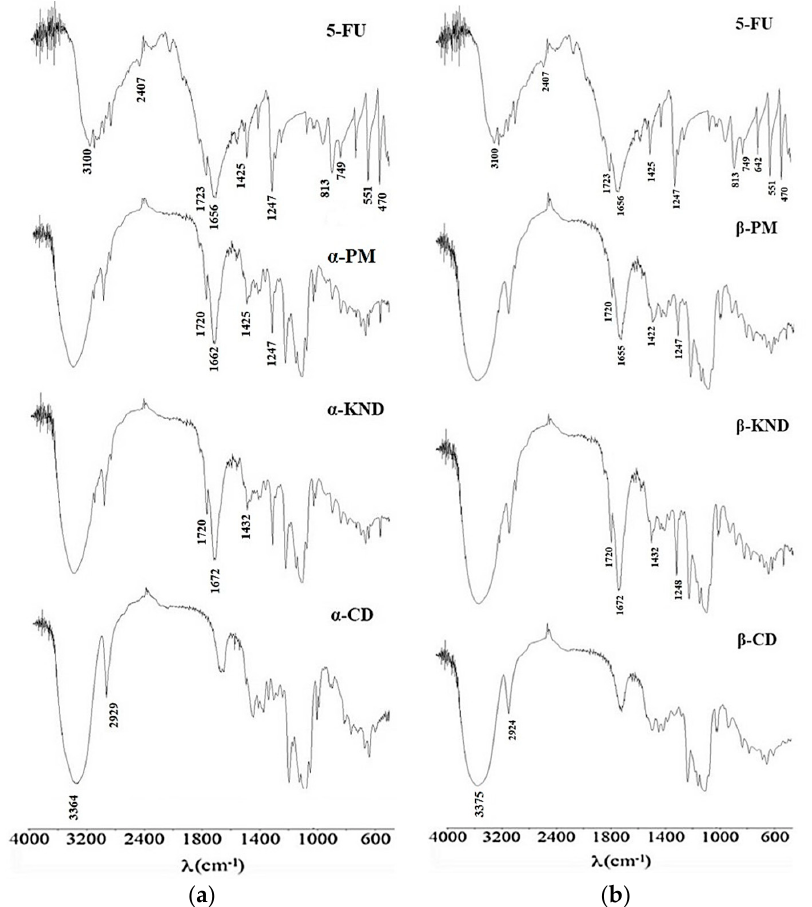
Figure 8. ( a ) FT-IR spectra of 5-FU, α -PM, α -KND, and α -CD; ( b ) FT-IR spectra of 5-FU, β -PM, β -KND, and β -CD.